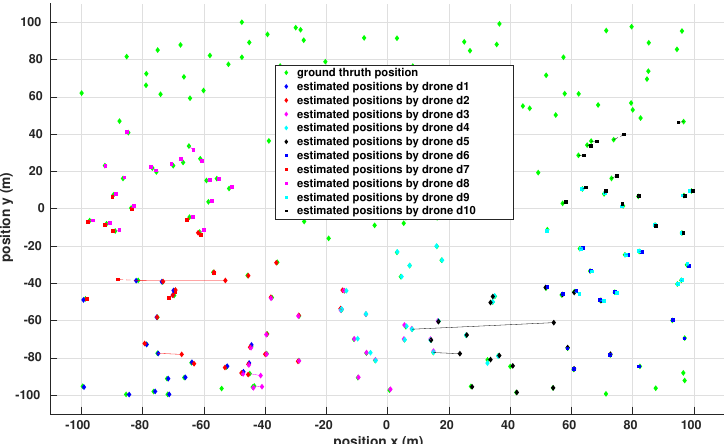
Figure 9. Localization of anchors by a fleet of drones. The colors correspond to the different drones and the corresponding located